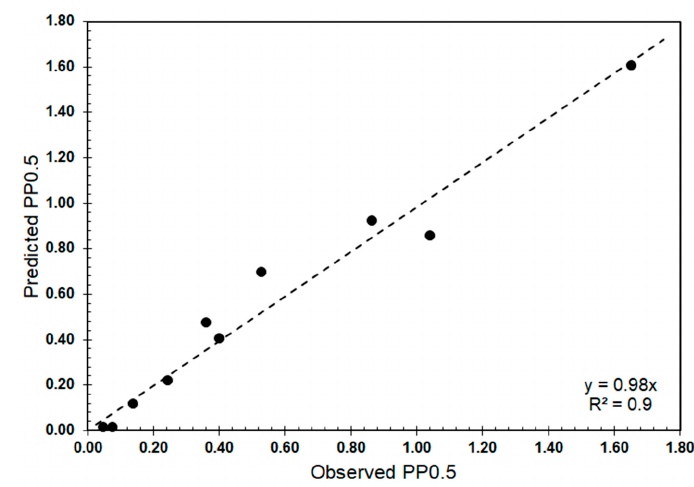
Figure 12. Comparison of %pp0.5 estimated from the spectra of froth with %pp0.5 measured from froth solids. The dashed line represents the trend line.